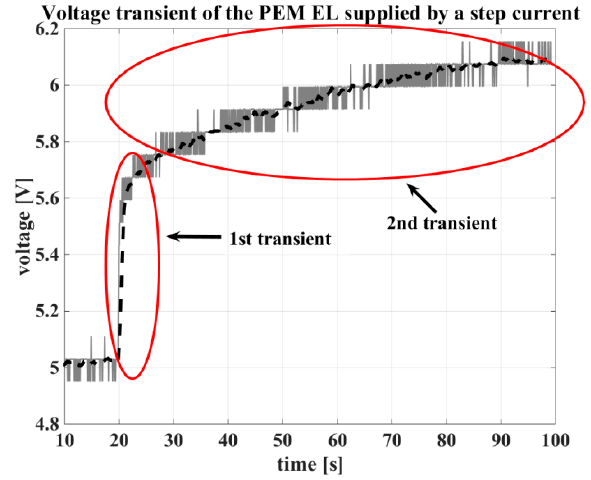
Figure 9. Zoom of the transient with exponential curves.